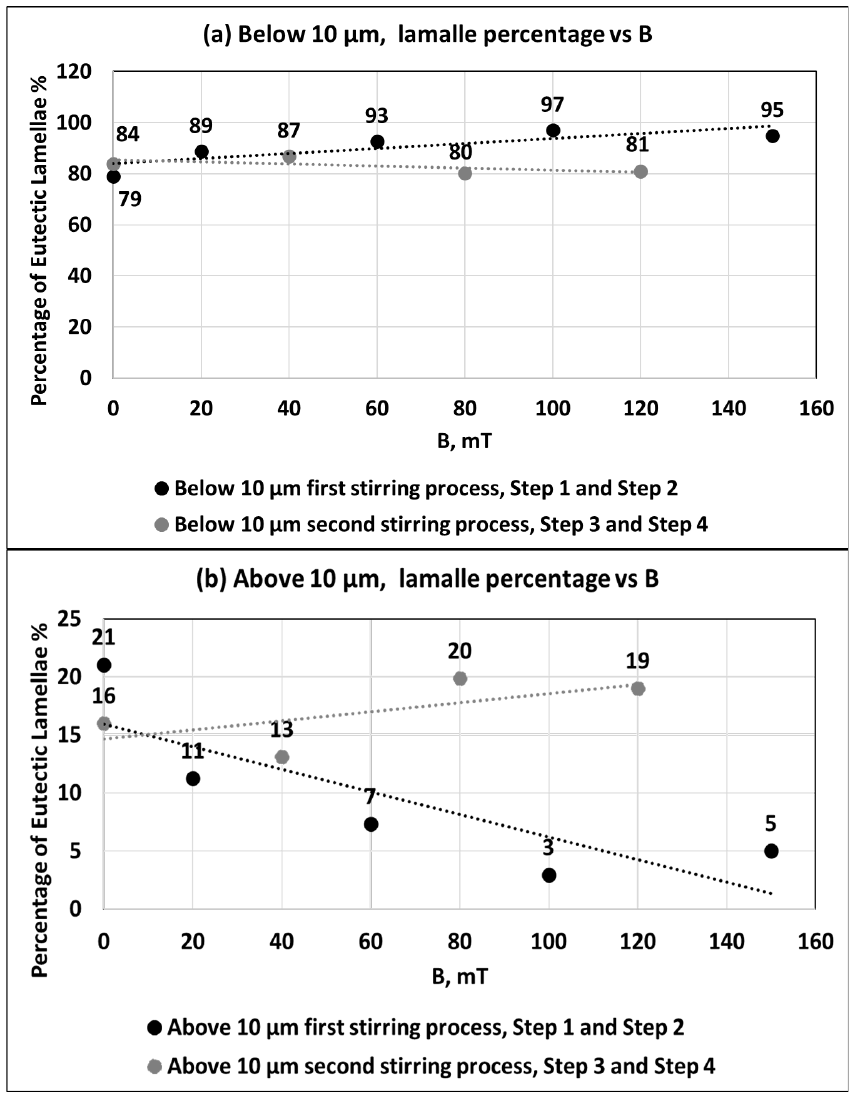
Figure 6. Length of Si eutectic plate vs. magnetic induction (B), ( a ) below 10 μm, ( b ) above 10 μm.